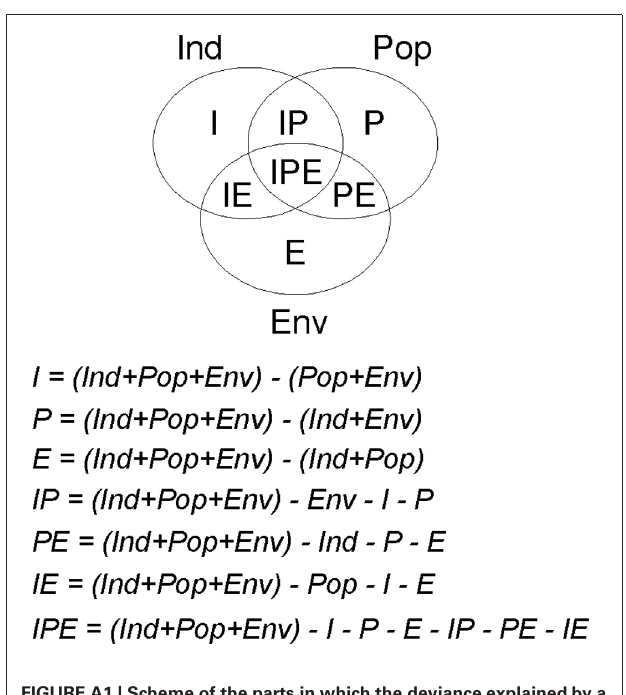
FIGURE A1 | Scheme of the parts in which the deviance explained by a final model can be split by variation partitioning procedures, and the subtraction rules used for this purpose. For the variation partitioning we first determined the total amount of deviance explained by the final model, and secondly we developed partial models, i.e., the models adjusted independently with the predictors related to each factor (individual host: Ind; host population: Pop; and environment: Env), as well as with those of each pair of factors (Ind + Pop, Ind + Env, and Pop + Env), and estimated the amounts of deviance explained by each of these six partial models. The values of the deviance explained for the final model (Ind + Pop + Env) and for the partial models were used in the following subtraction